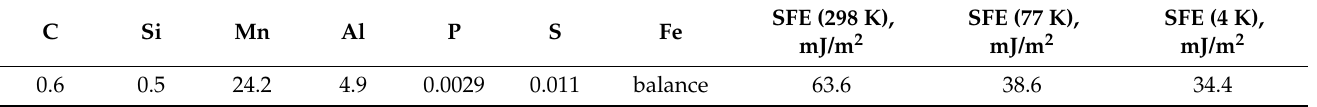
Table 1. Chemical compositions and SFEs of the steel,